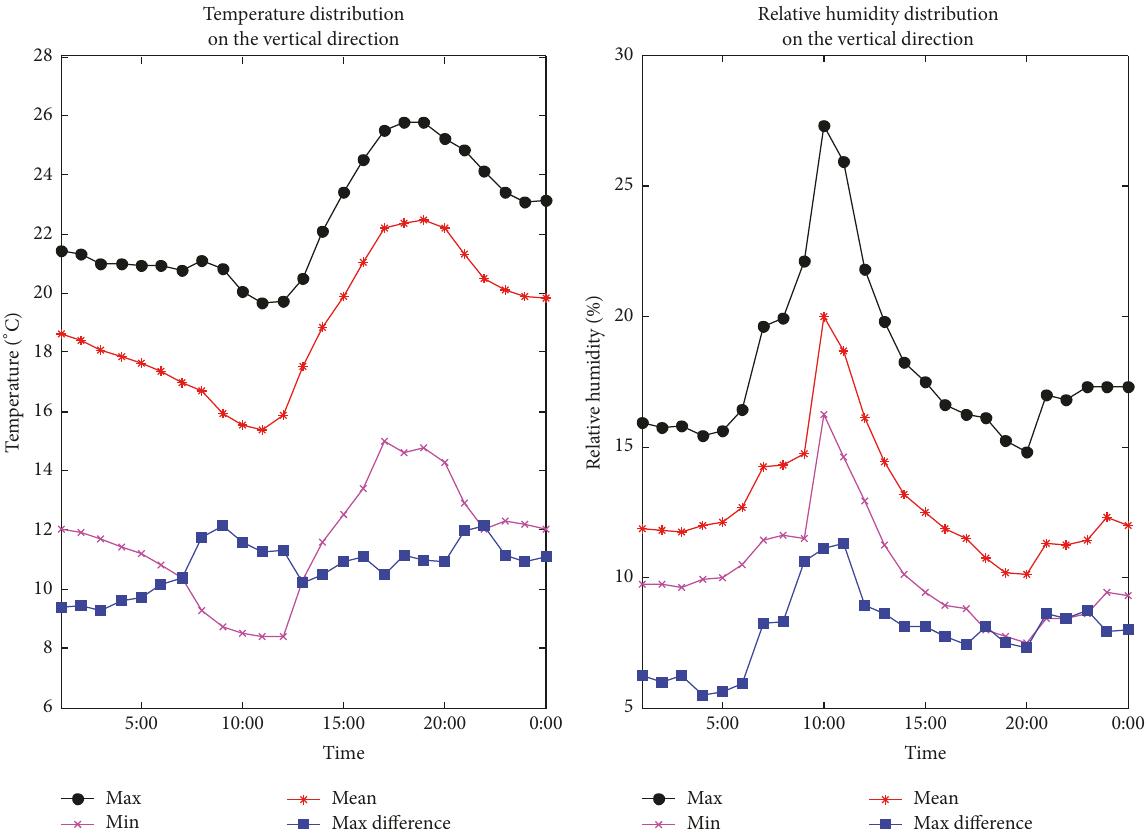
Figure 8: Maximum, minimum, and mean value of temperature and relative humidity on the vertical direction.